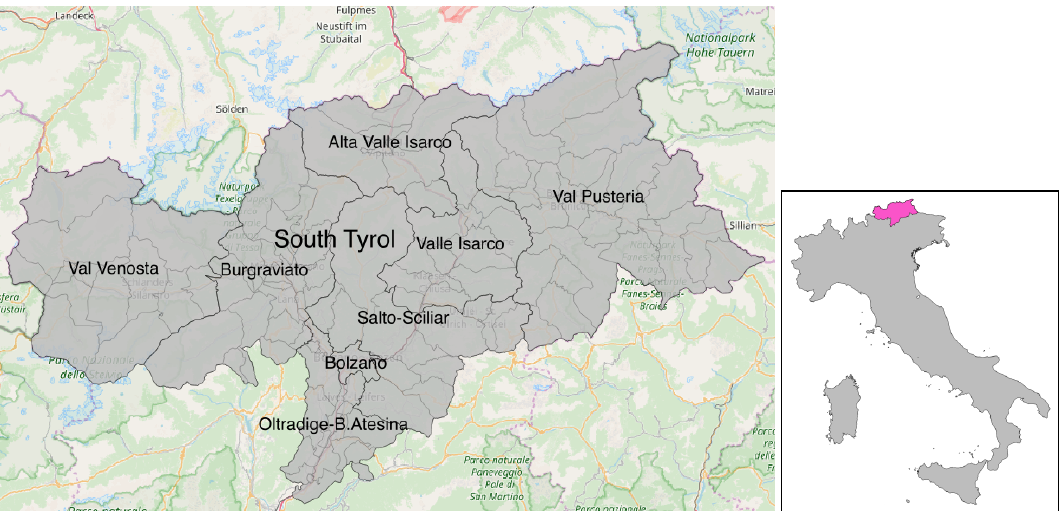
Figure 2. The province of South Tyrol.